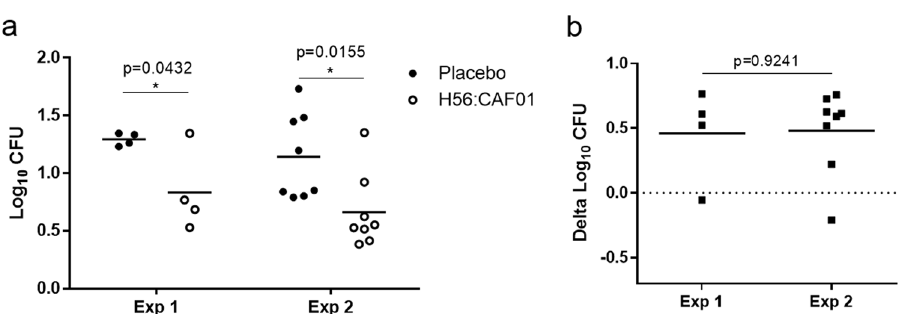
Figure 4. Mycobacterial growth inhibition is reproducible, allowing for comparison between experiments. Splenocytes from mice immunised three times s.c. with 2-week intervals with H56 in CAF01 or given placebo (Tris buffer) were isolated one week after the last immunisation and used in MGIA. Experiment (Exp) 1 and 2 represent two independent immunisation experiments. ( a ) Log 10 CFU values after subtracting the direct- to-MGIT controls from the individual log 10 CFU values. ( b ) Delta log 10 CFU values represent the H56:CAF01 induced mycobacterial growth inhibition and were calculated by subtracting the individual log 10 CFU values in the immunised H56:CAF01 groups from the mean of the respective control group (Placebo). Solid lines represent the mean Log 10 CFU of 4 and 8 mice, for experiment 1 and 2 respectively, measured in duplicates. t-test, * p <